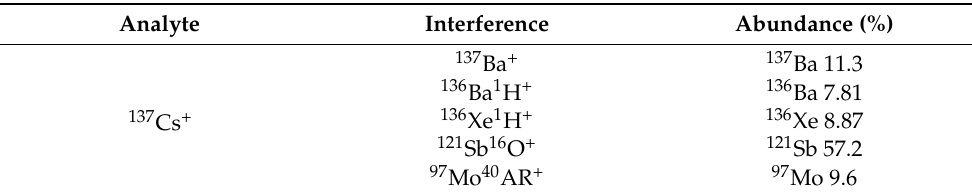
Table 1. Interferences affecting the determination of 137 Cs + by mass spectrometry, reprinted with permission from